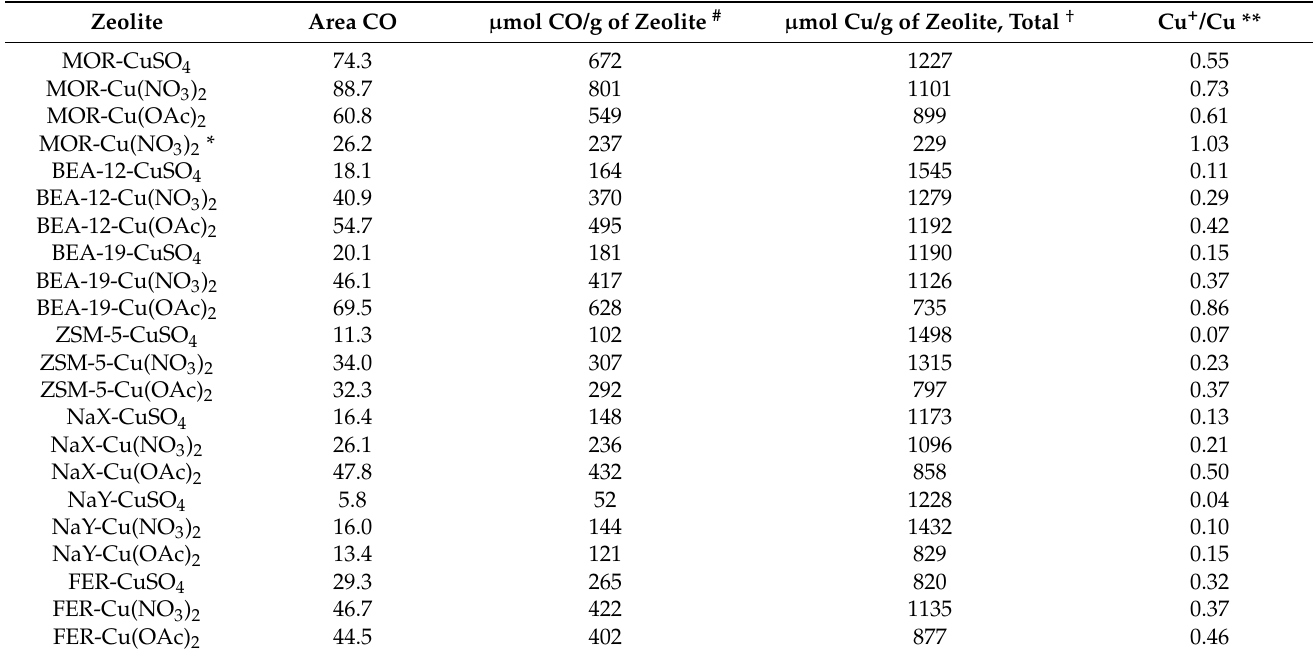
Table 3. CO adsorption-desorption FTIR data, scaled to 10 mg, ( ε = 13.5 cm µ mol − 1